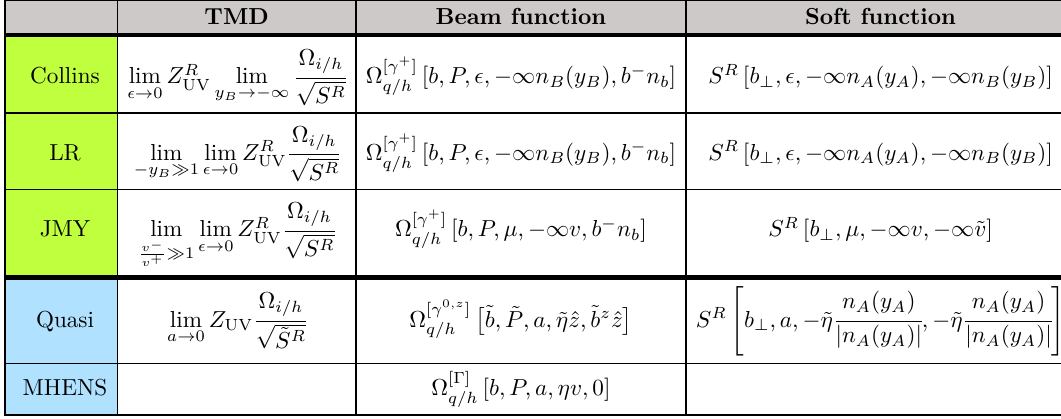
Table 1 . Overview of TMD schemes, as presented in section 2. The correlator Ω is a function of Lorentz invariants constructed from its arguments. See table 2 for a comparison of parameter values, Wilson line definitions, and Lorentz invariants in each